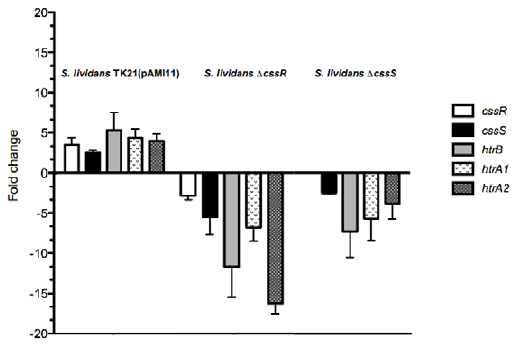
Figure 1. Regulation of the S.lividans secretion stress response. Quantitative RT-PCR analyses showed that the expression of the cssS , cssR and the three HtrA-like protease genes was upregulated in the S. lividans wild type strain overproducing amlB , S. lividans TK21 (pAMI1), whereas their expression resulted down regulated in the S.lividans D cssR and S. lividans D cssS strains. The expression of cssR was not affected in the CssS mutant strain. The values are the mean of at least three biological replicates. Bars show standard